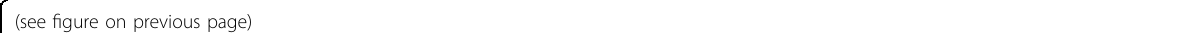
Fig. 2 Nuclear shape alteration induced by H 2 O 2 treatment during mitosis is rescued by antioxidants. a Cells were pretreated (NAC + H 2 O 2 ) or not pretreated (H 2 O 2 ) with NAC for 30 min. Then, mitotic cells were isolated through shake-off and treated with 100 μ M H 2 O 2 for 10 h. Left panel: After 10 h, the nuclear shape was assessed by Lamin B1 staining (red). Scale bar: 20 μ m. Right panel: Percentage of cells with abnormal nuclear shapes. The results are shown as the means ± SDs of three independent experiments ( n = 300). * P < 0.05; ** P < 0.01 by Student ’ s t -test. b Mitotic cells were pretreated or not pretreated with NAC for 30 min and were then incubated with 100 μ M H 2 O 2 for 1 h. Intracellular ROS levels were measured by FACS analysis using DCF-DA. c HeLa cells were transfected with an HA-catalase expressing vector, and mitotic cells were then treated with or without 100 μ M H 2 O 2 for 10 h. Left panel: nuclear shape of HA-catalase (red)-transfected cells. Scale bar: 20 μ m. Right panel: percentage of cells with abnormal nuclear shapes according to HA-catalase expression. The results are shown as the means ± SDs of three independent experiments ( n = 100). * P < 0.05; ** P < 0.01; *** P < 0.001 by Student ’ s t -test. d HeLa cells were transfected with pHyper-Cyto and then with pcDNA3 or HA-Catalase. Changes in intracellular H 2 O 2 levels are expressed as the fl uorescence intensity ratios upon excitation with 488 and 405-nm lasers. Representative time-lapse fl uorescence images (30 s intervals for 25 min) of pHyper-cyto sensors in mitotic HeLa cells treated with 100 μ M H 2 O 2